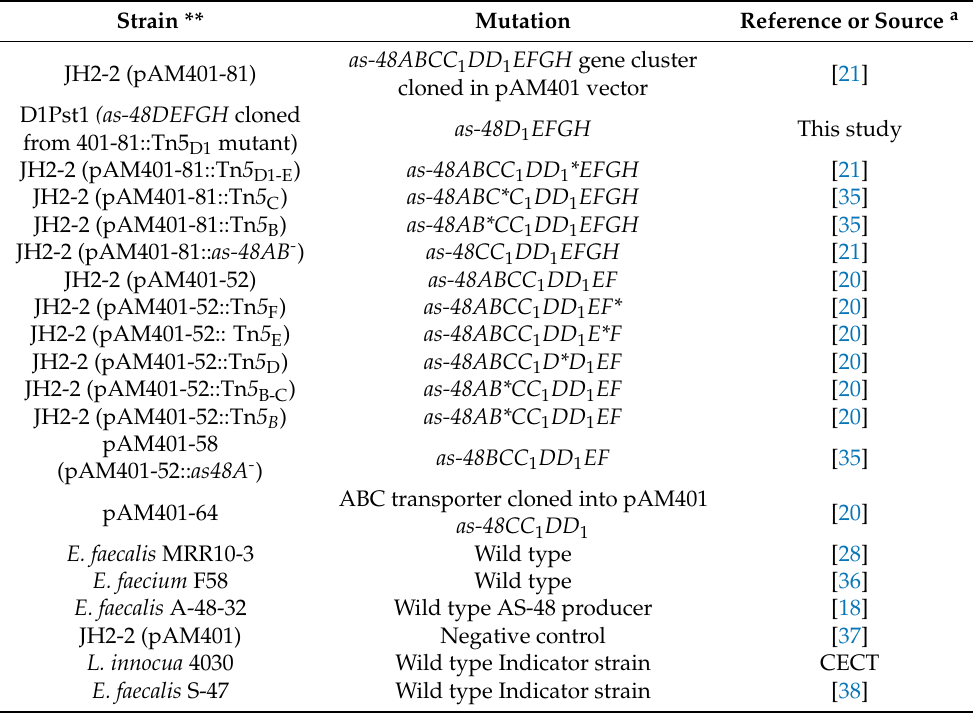
Table 1. Bacterial strains used in the present